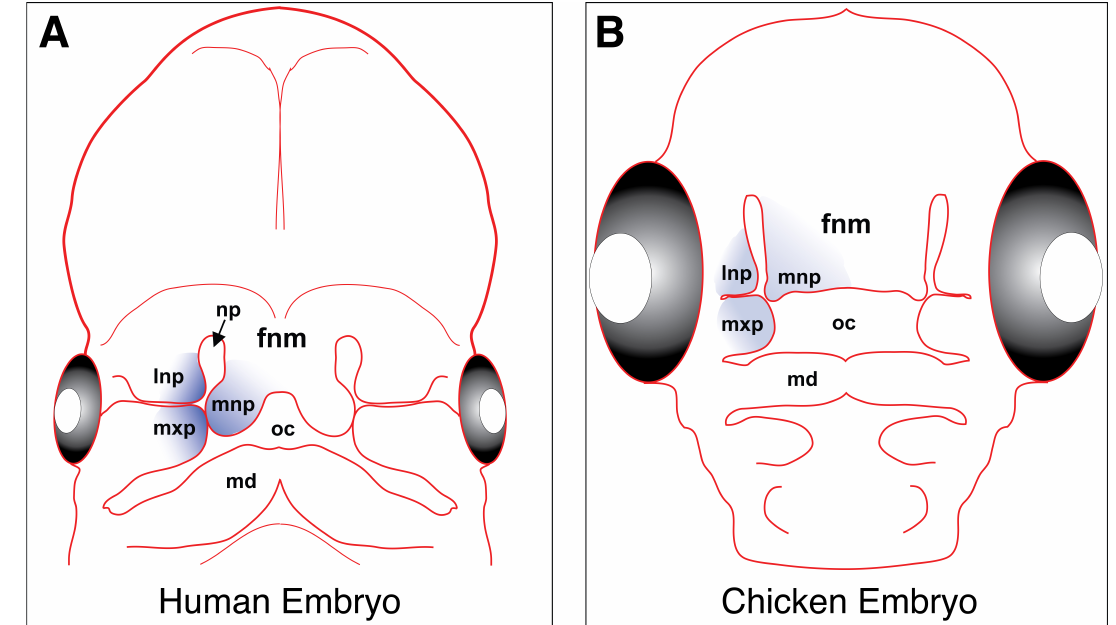
Figure 3. Fusion of the upper lip in human ( A ) and chicken ( B ) embryos reveals structural similarities. Across amniotes, the face is assembled from five main craniofacial prominences: the frontonasal mass (fnm), lateral nasal prominence (lnp), medial nasal prominence (mnp), maxillary prominences (mxp) and the mandibular prominences (md). The primary palate (upper lip / beak and nasal cavities / nasal pits [np]) forms from the fusion of the maxillary and lateral nasal prominences with the medial nasal prominence (highlighted in blue), although there is some variation in this process across di ff erent lineages